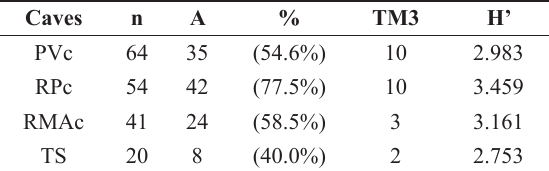
Number of species, number and percentage of species after second collection for the caves with five or more collections and H’ index. PVc - Parede Vermelha cave; RPc - Rio dos Pombos cave; RMAc - Ressurgência do Morro de Alvo cave; TS - Torras System. n - number of total species in each cave; A - number of species after second collection; % - percentage of species after second collection; TM3 - number of troglobitic and troglomorphic species after second collection. H’ - Shannon